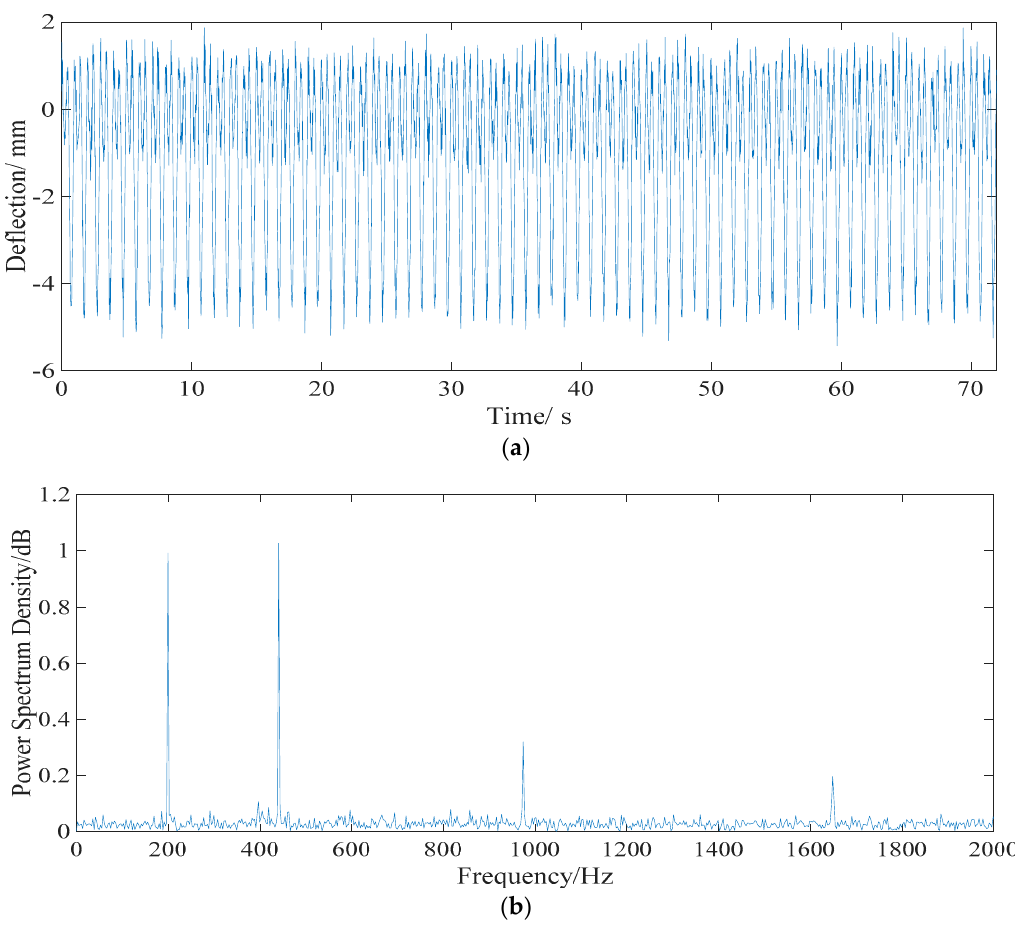
Figure 6 . Time history and frequency spectrum of live load deflection. ( a ) Time history data. ( b ) Frequency spectrum.